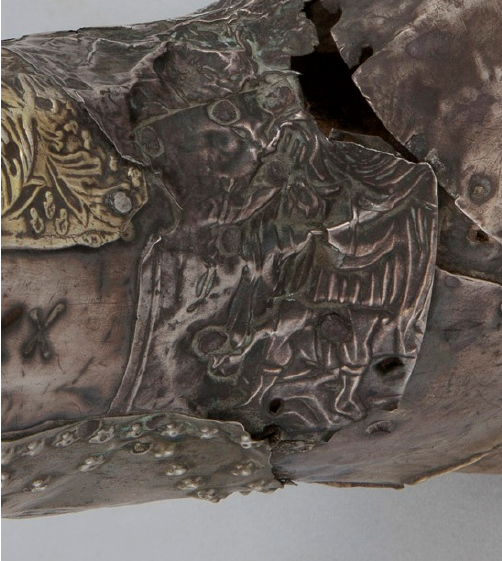
Figure 11. Leg-shaped reliquary (15th century) with ex-voto plates (18th century), Cathedral of Saint Tryphon, Kotor, photos by Stevan Kordi ć .